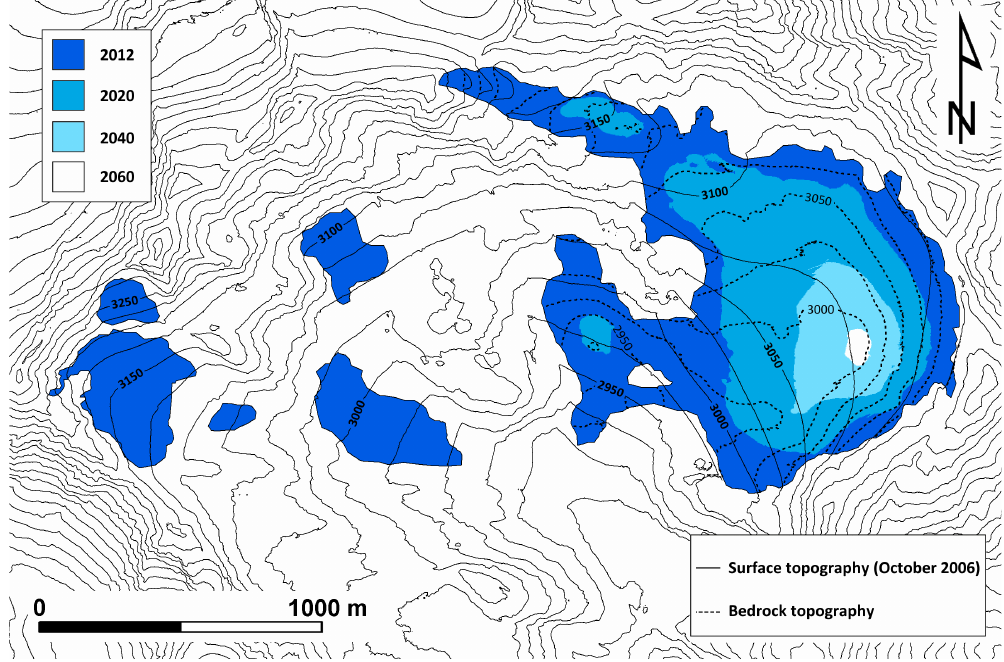
Fig. 13. Current (2012) and future extent of the Careser Glacier, assuming unchanged spatial distribution of the mean annual mass balance compared to the decade from 2003 to 2012 (Fig. 9), and negligible glacier motion. Table 4. Correlation coefficients calculated from the specific annual balances of Careser Glacier and other 15 glaciers in the Alps in the period from 1981 to 2010. Mass balance data have been taken from Fluctuations of Glaciers (WGMS, 2012 and earlier volumes), except for La Mare glacier (Carturan et al., 2009). Numbers in brackets indicate partial coverage (years) for the examined decades. Correlations which are not significant at the 0.05 level are marked in bold type. Italian Alps Ortles-Cevedale group Western Alps Eastern Alps Sfor- Fontana Lunga La Ciar- Pen- Mala- zellina Bianca Mare doney dente valle